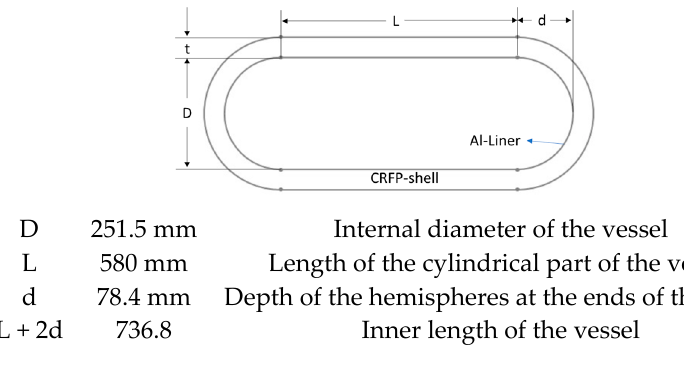
Figure A2. Sketch of the Al-liner + CRFP and the dimensions.